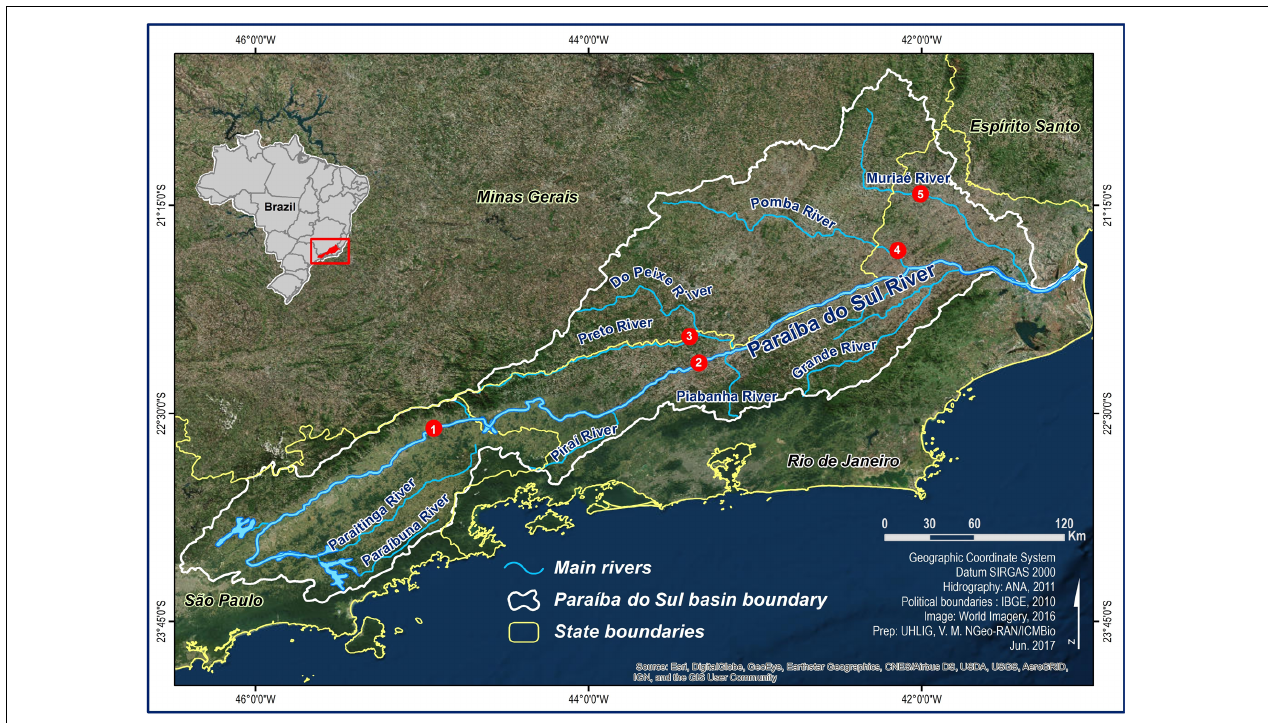
FIGURE 1 | Sampling sites for Steindachneridion parahybae in the Paraíba do Sul River basin. 1 – Paraíba do Sul River – SP (PSP), 2 – Paraíba do Sul River – RJ (PRJ), 3 – Preto River - RJ (PRE), 4 – Pomba River – RJ (POM), 5 – Muriaé River – RJ